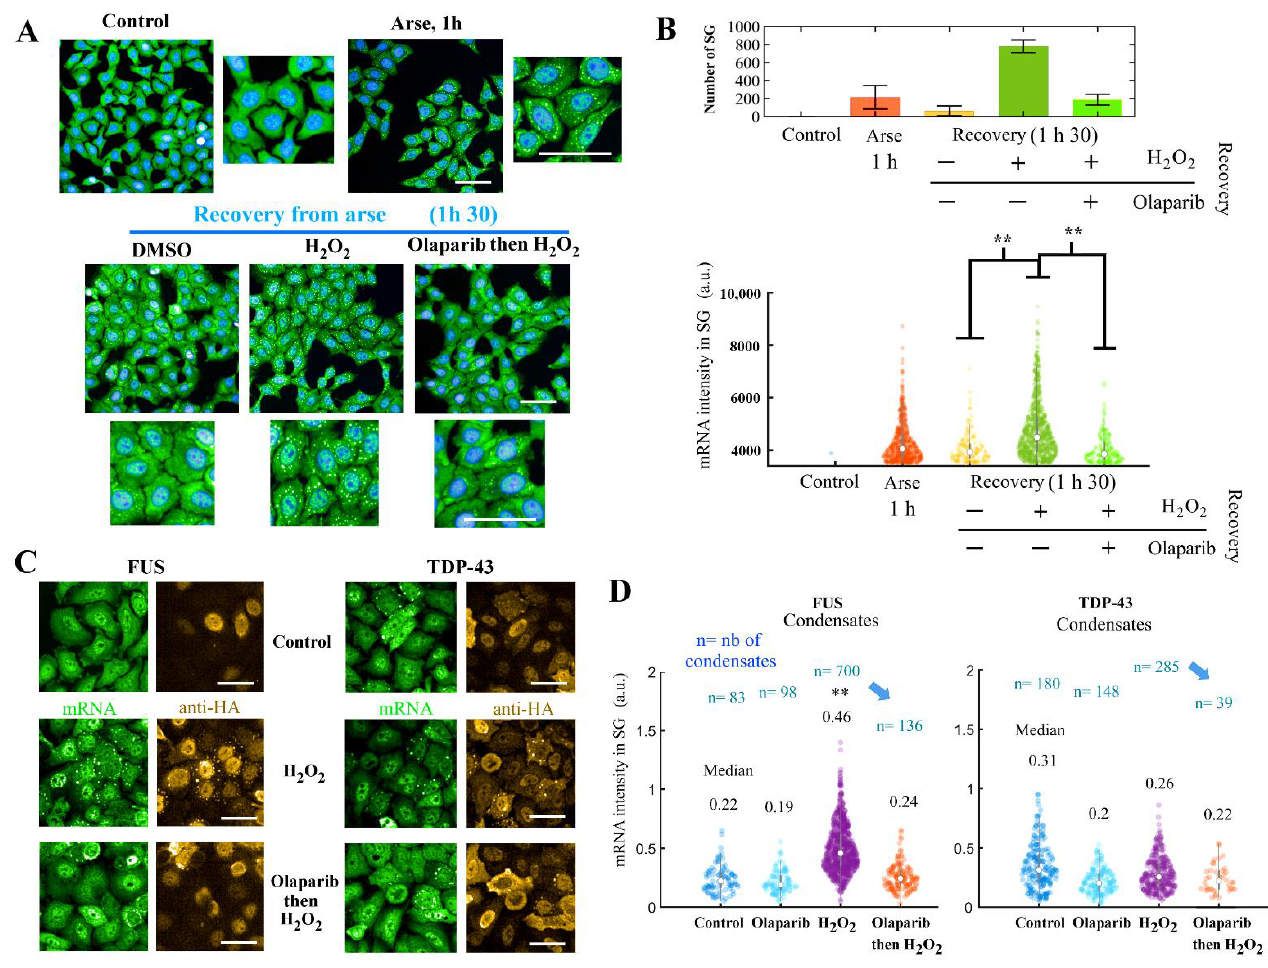
Figure 5 . Pre-formed SGs become persistent after PARP1 activation. ( A ) Representative images of HeLa cells exposed to the indicated treatments (300 µM arsenite; 300 µM H 2 O 2 ; 3 µM olaparib, 1 h prior to and during indicated treatment). Green: mRNA (in situ hybridization with cy3-labelled poly(dT) probes). Blue: DAPI. Scale bar: 10 μm. During the indicated recovery period, cells were washed out with culture medium with or without olaparib when indicated. ( B ) Automatic detection of SGs reveals an inhibition of SG disassembly during stress recovery when cells were exposed to H 2 O 2 during the recovery period. mRNA detection: in situ hybridization with poly(dT) probes. **, p < 0.01, t test. White dots represent the mean value of the data. ( C ) Representative images of HeLa cells overexpressing HA-tagged TDP-43 or FUS exposed to the indicated treatments (300 µM H 2 O 2 for 1 h; 10 µM olaparib, 1 h prior to and during indicated treatment). Green: mRNA (in situ hybrid- ization with cy3-labelled poly(dT) probes). Gold: anti- HA antibody. Scale bar: 10 μm. ( D ) Analysis of the mRNA intensity in FUS- or TDP-43-rich SGs. The number of condensates (n) in the presence of H 2 O 2 or other conditions for cells expressing HA-tagged FUS or TDP-43. **, p < 0.01, t -test. White dots represent the mean value of the